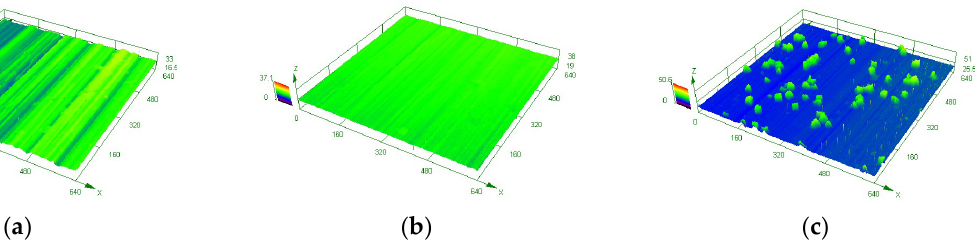
Figure 10. Elements distributions of the surface of tungsten in tap water for 60 days. (( a ) is the SEM image; ( b ) is the mapping of Ca element; ( c ) is the mapping of O element).